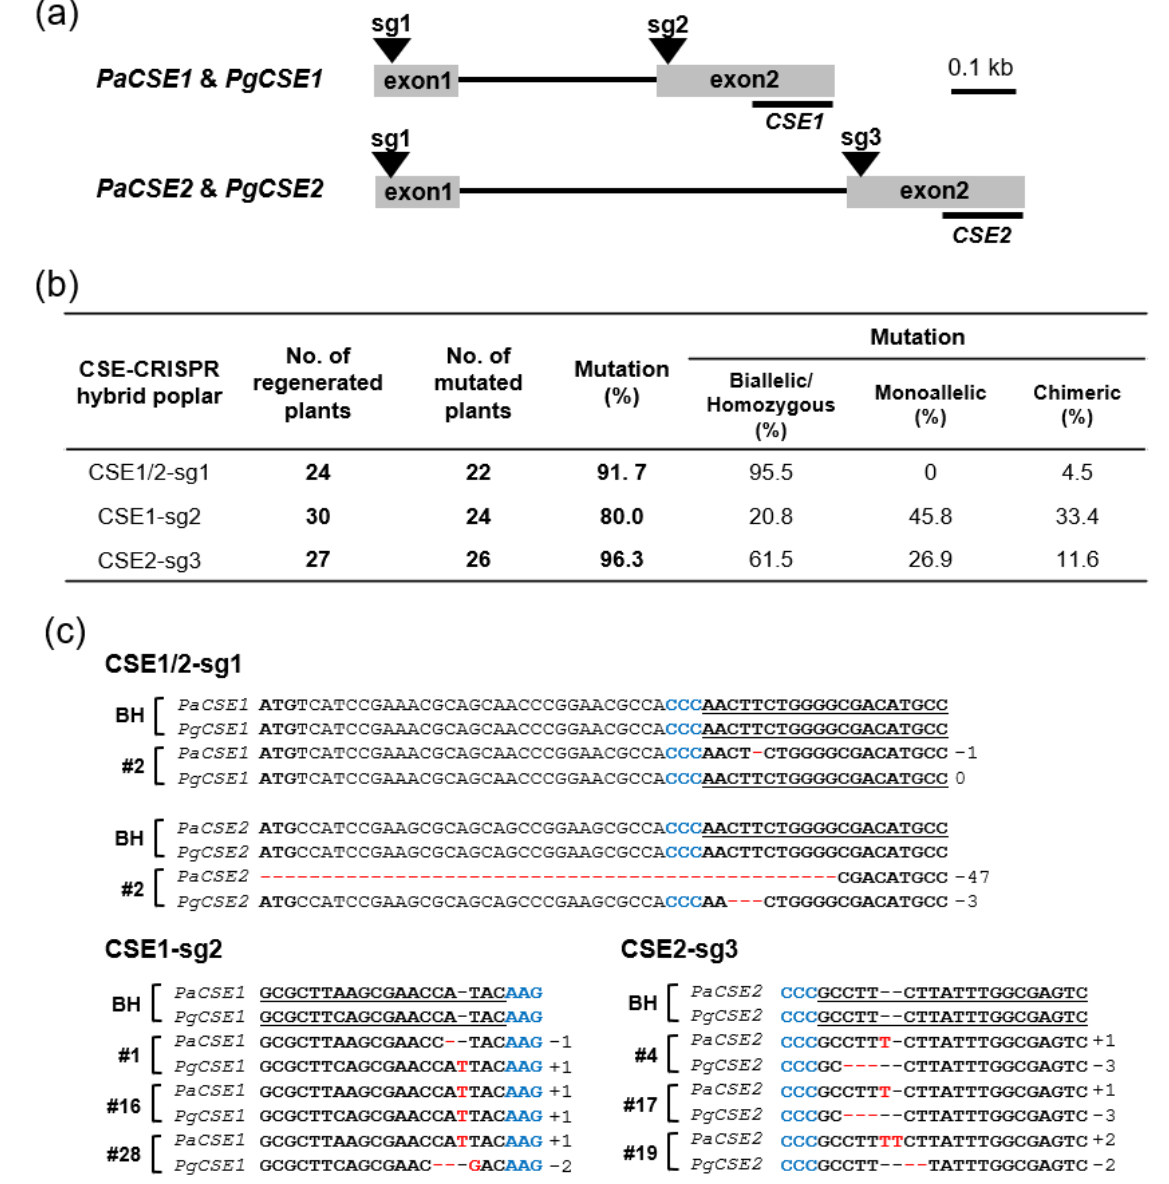
Figure 1. Production of transgenic hybrid poplar with CRISPR-knockout of CSE genes. ( a ) Gene structure of CSE genes with locations of single guide RNA (sg1–sg3) target sequences. PaCSE1/2 and PgCSE1/2 indicate CSE genes from Populus alba and P. glandulosa , respectively, in the hybrid poplar ( Populus alba × P. glandulosa , clone BH) used in this study. C-terminal region of exon2 in each CSE gene for quantitative real-time PCR (RT-qPCR) target was underlined with a gene name. ( b ) Summary of the genotypes of the transgenic CSE-CRISPR hybrid poplars by targeted deep sequencing. Genotyping of the mutated sequences in transgenic hybrid poplars was performed using the Illumina MiniSeq platform (see, Methods). ( c ) Indel mutations of the selected CSE-CRISPR hybrid poplars. CSE1/2-sg1 (line #2) targeted the first exon of PaCSE1/2 and PgCSE1/2 genes; CSE1-sg2 (lines #1, #16, #28) targeted the second exon of PaCSE1 and PgCSE1 ; CSE2-sg3 (lines #4, #17 #19) targeted the second exon of PaCSE2 and PgCSE2 . PAM sequences are shown in blue and target sequences are underlined. Identified indels in target sequences of each line are highlighted in red and the indel numbers are shown on the